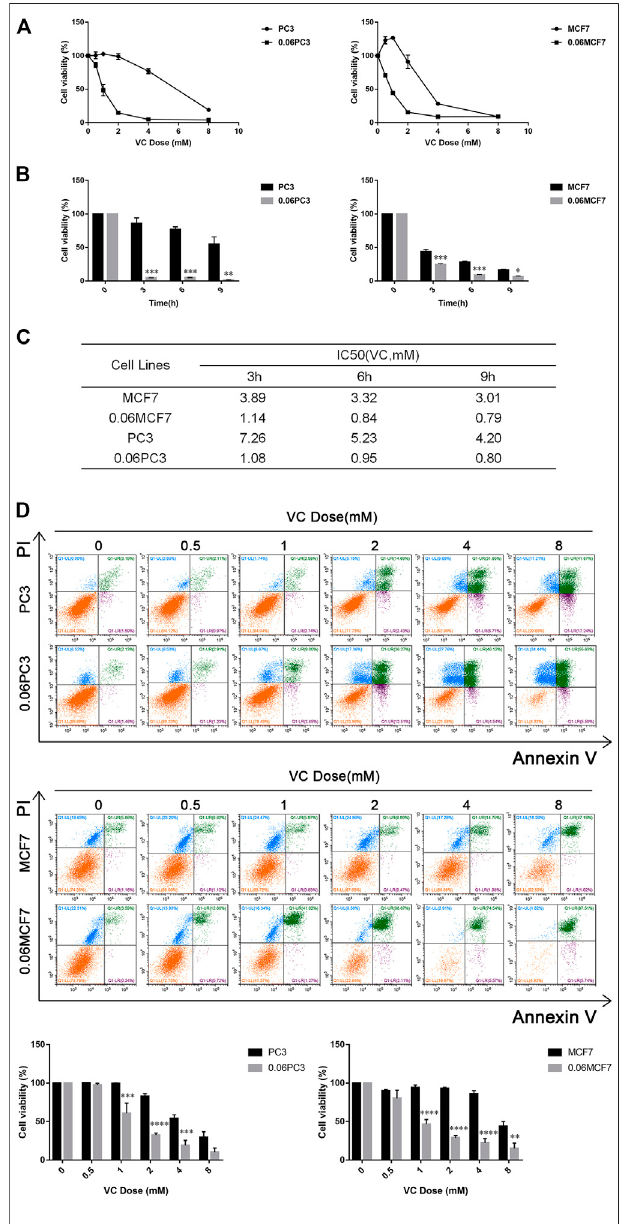
FIGURE 2 | The cytotoxicity of VC increases in cancer cells overexpressed GS. (A) Cell viability evaluated byCCK-8 assay after treatment with different doses of VC for 6 h. (B) Cell viability evaluated by CCK-8 assay after treatment with VC (4 mM) for the indicated times. (C) IC50 of VC in cells evaluated by CCK-8 assay for the indicated times. (D) Cell apoptosis evaluated by annexin-V/PI assay after treatment with different doses of VC for 16 h. All data are presented as means ± SEM, * p < 0.05, ** p < 0.01, *** p < 0.001, **** p < 0.0001, n (cid:2) 3. VC, Vitamin